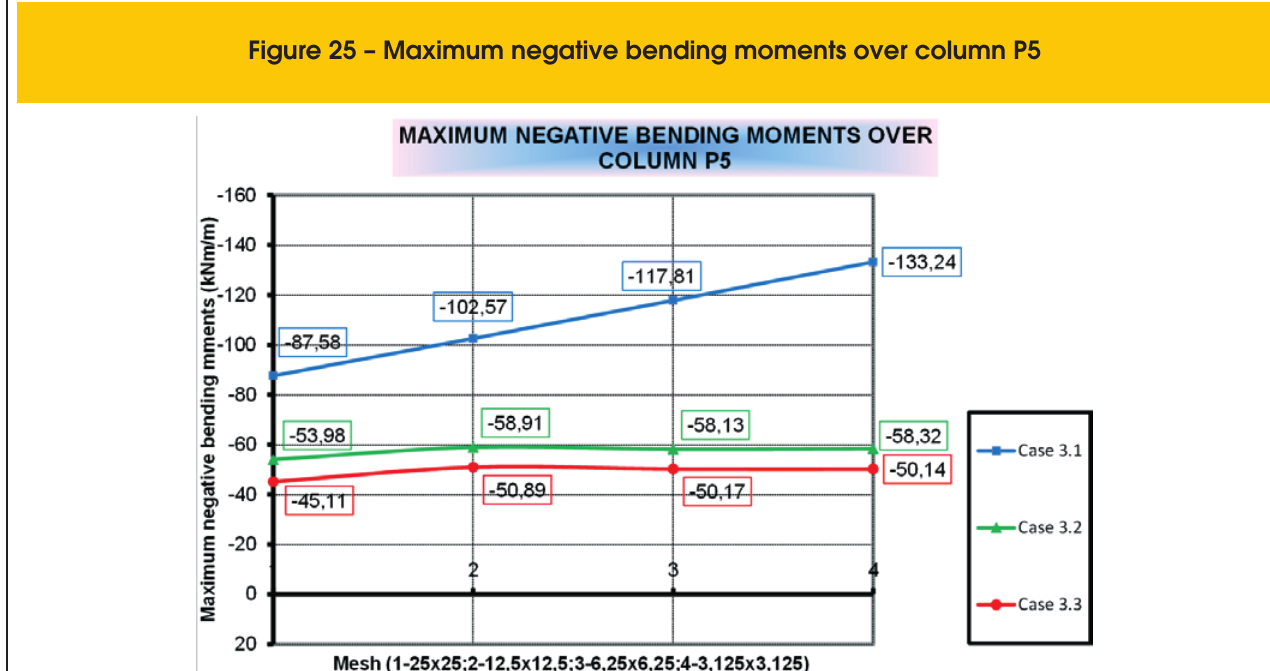
Figure 25 – Maximum negative bending moments over column